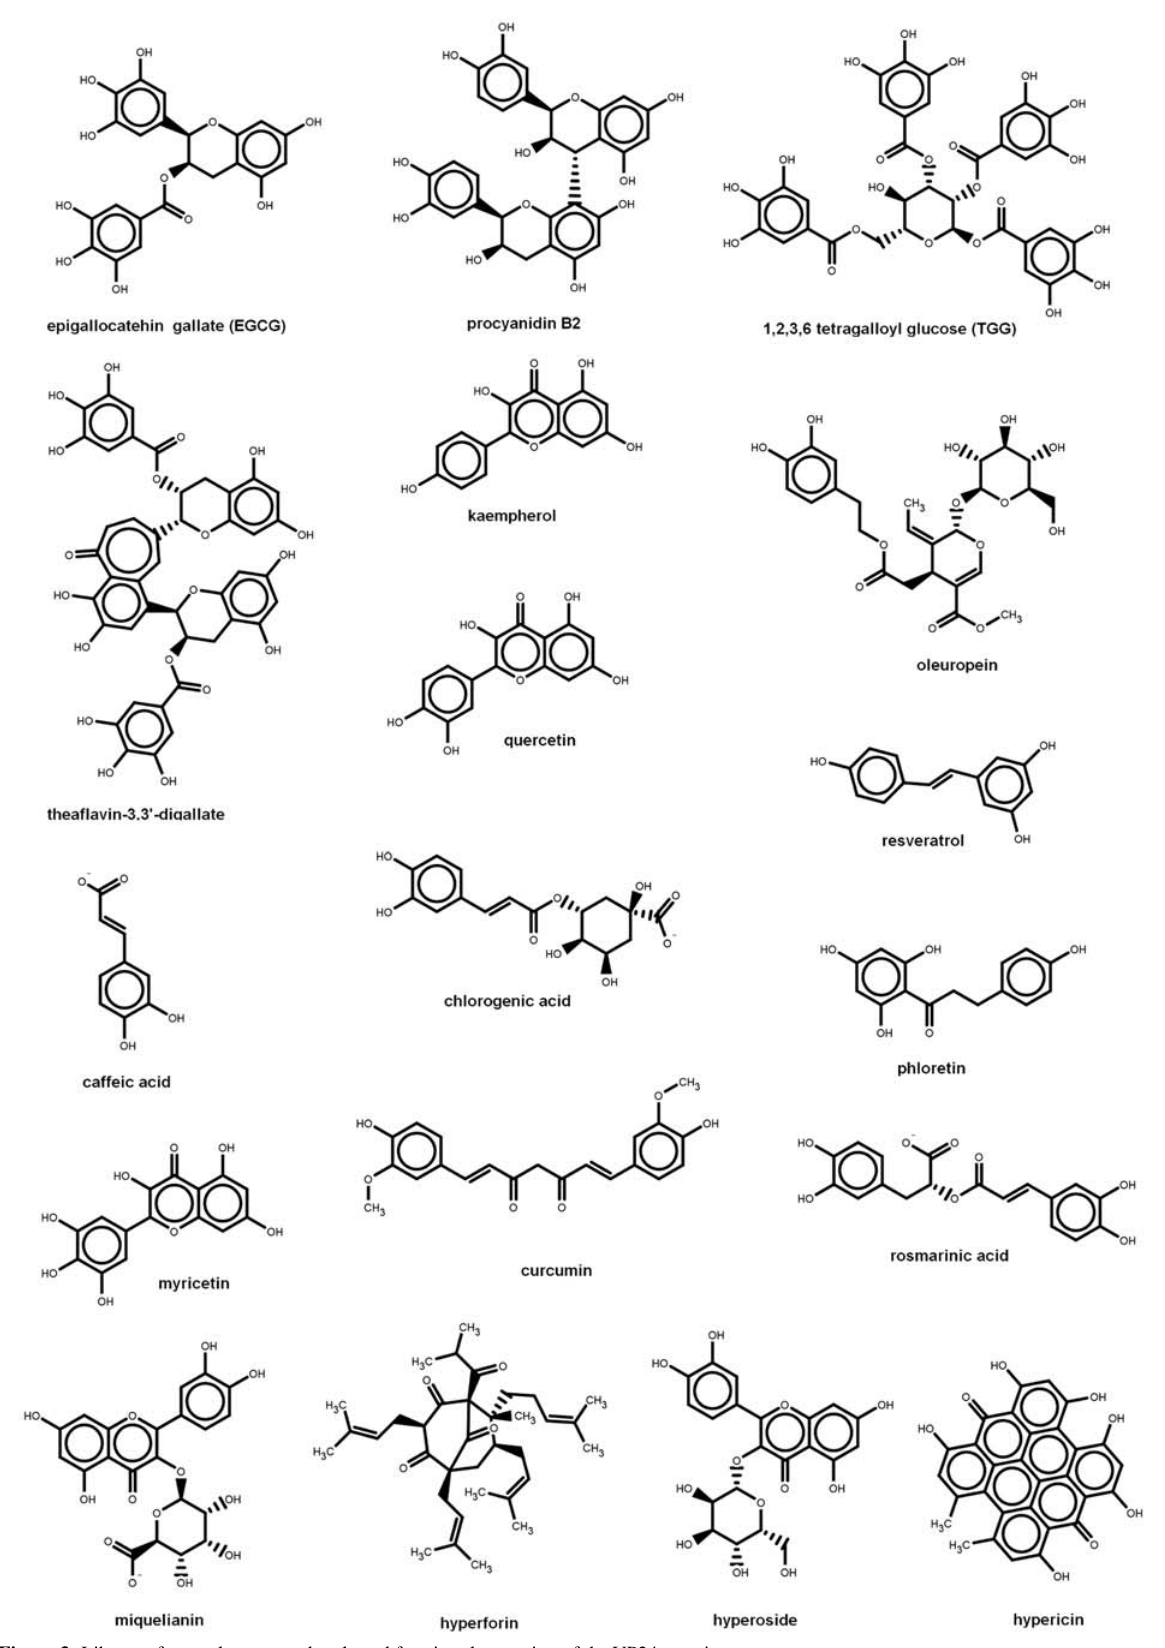
Figure 3: Library of natural compounds selected for virtual screening of the VP24